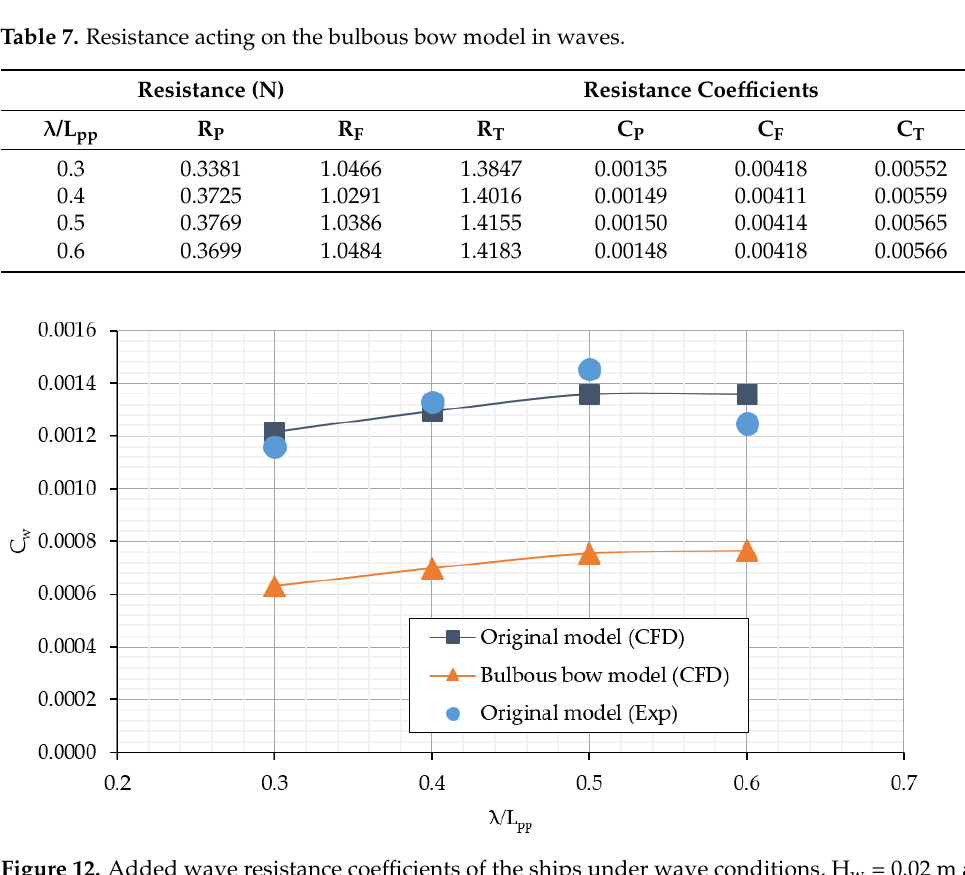
Table 5. Resistance acting on the bulbous bow model in calm water.